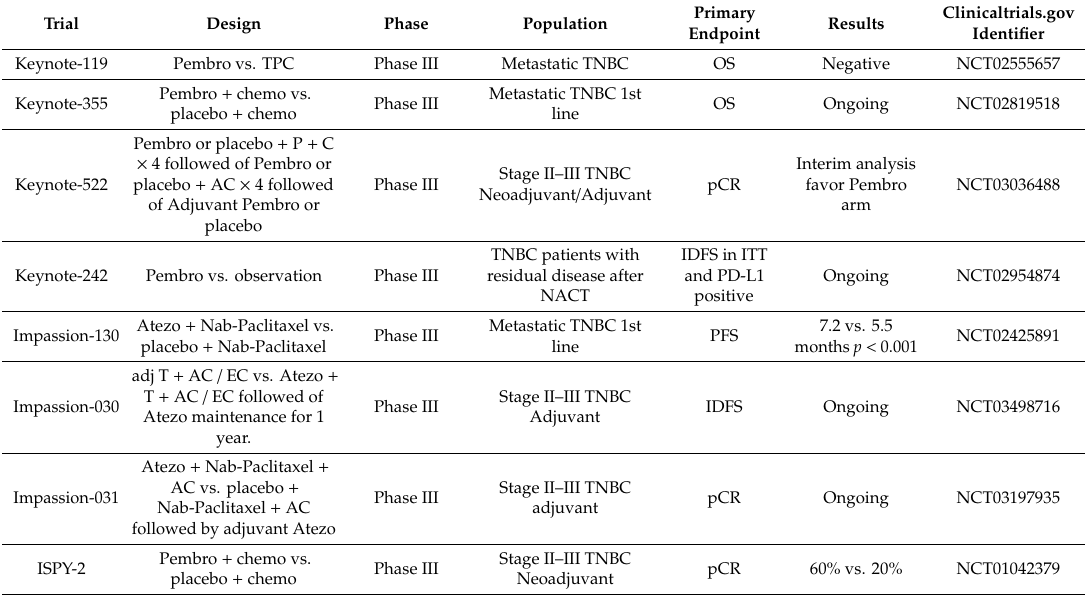
Table 3. Summary of Clinical Trials for Immune Checkpoint